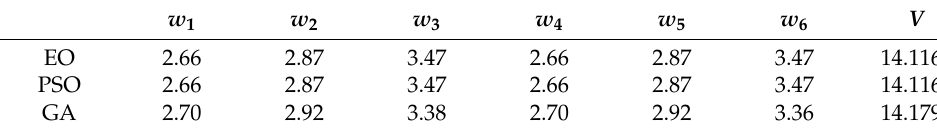
Table 4. Allocated tasks for the AUVs in the middle-scale system.